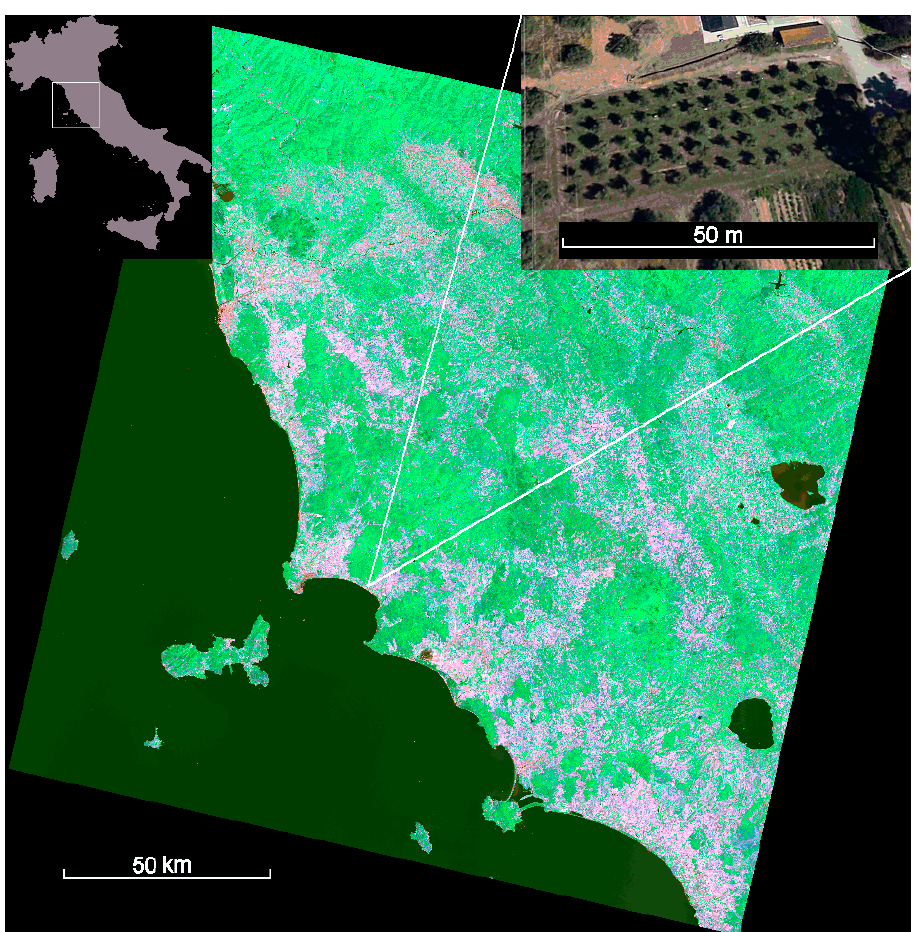
Figure 1. Landsat OLI frame of Tuscany taken on 16 June 2013 with position of the study area; the top left box shows the position of the frame in Italy, while the top right box shows a Google Earth IKONOS pan-fused image of the examined olive orchard taken on 5 June 2013.